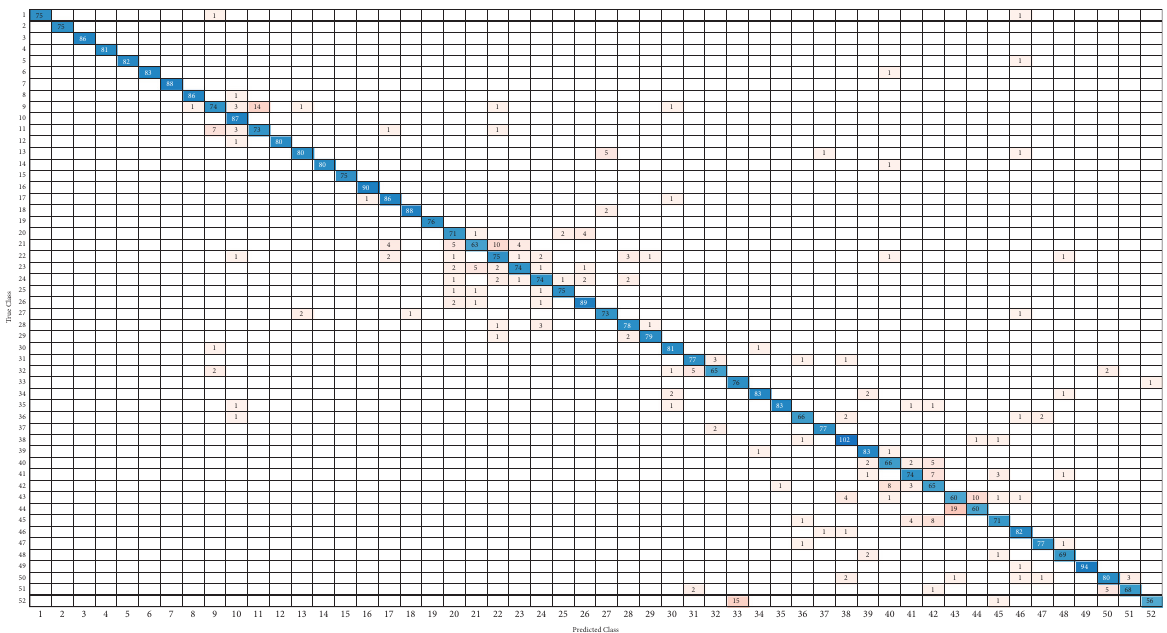
Figure 5: The confusion matrix chart of DBDF possible. A comparison of different classification networks without downsampling is shown in Table 6. In the same classification network, the validation accuracy with down- sampling is higher than that without downsampling, and using downsampling saves more training time.